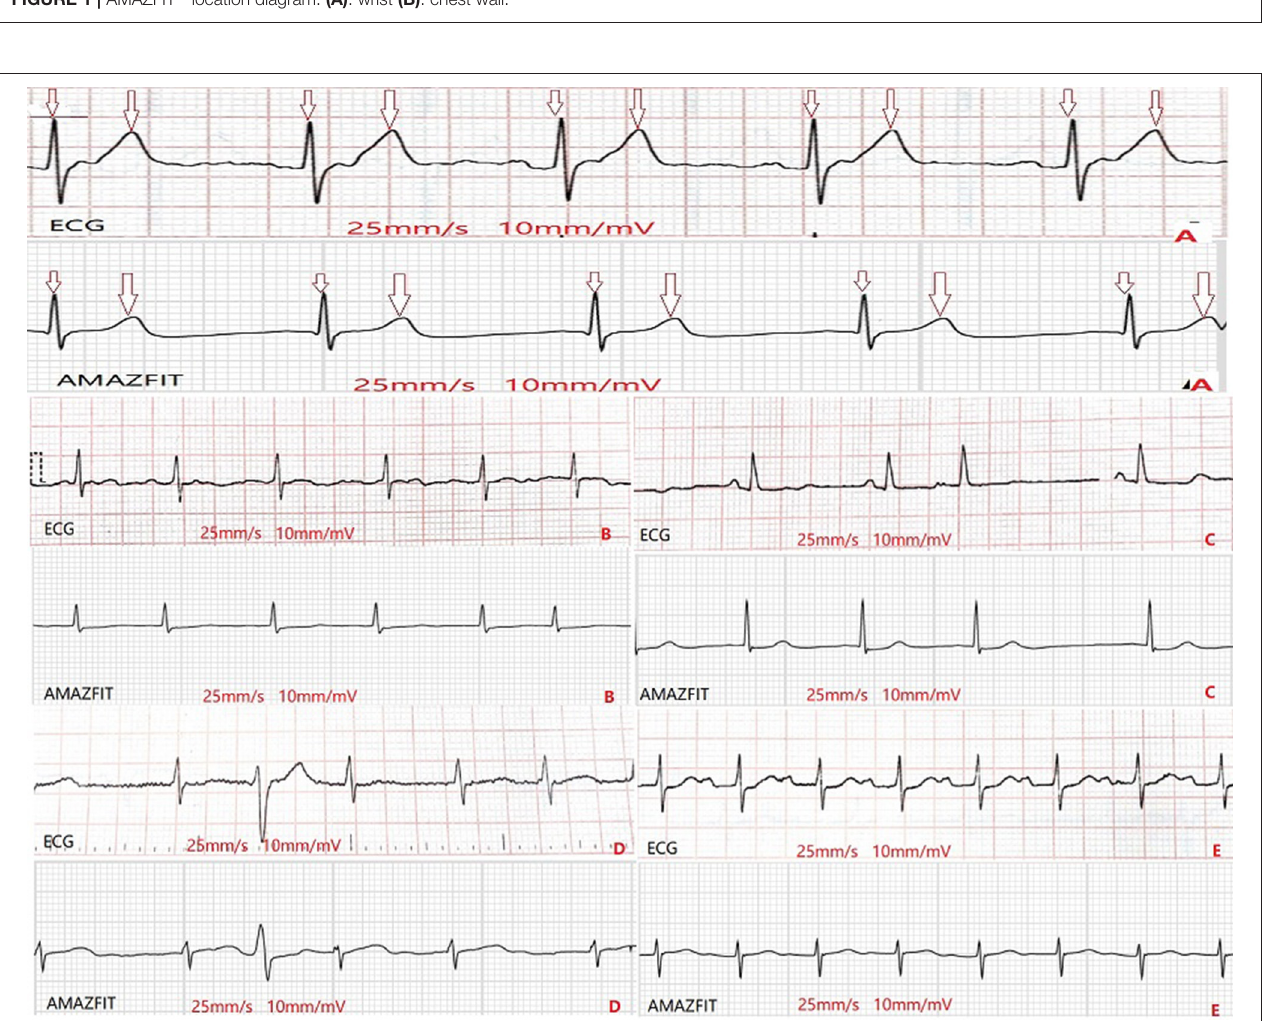
FIGURE 2 | Comparison of the waveforms from ECG and from AMAZFIT ® . (A) : sinus rhythm; (B) : AF; (C) : PACs; (D) : PVCs; (E) : first-degree AVB. AF, arterial fibrillation; PACs, premature arterial contractions; PVCs, premature ventricular contractions; AVB, atrioventricular block.